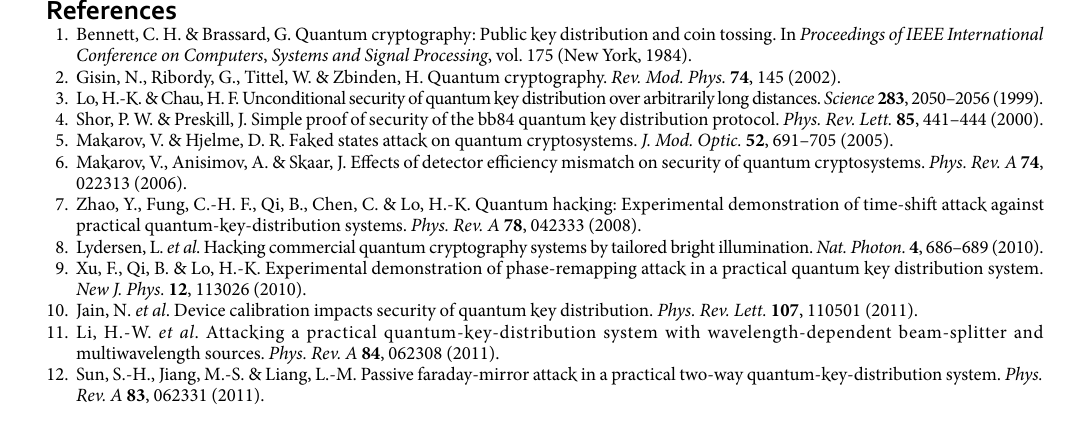
Measurement method. Figure 6(a) shows the detector circuit diagram in our experiment. The APD is biased by a high voltage from analog tap T1 with a biased resistance of 1 MΩ. Tap T2 is an analog tap of avalanche signals with a load resistance of 50 Ω. We do not re-engineer exact detector circuit in commercial SPDs, which contain filter circuits and a fast comparator. Figure 5(b) shows the measurement setup used to measure intrinsic imperfections of APDs. To produce trigger pulses, a laser diode sends light pulses, and then they are attenuated by an intensity modulator controlled by directly applying the pulsed voltage from a function generator (Tektronix AFG3022C). The detector blinding is simulated by directly applying a high voltage for tap T1 from a home-made DC power. An